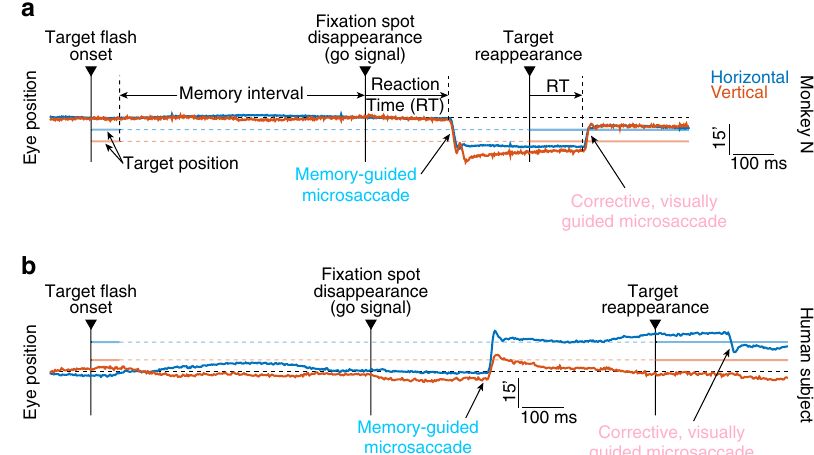
Fig. 1 Memory-guided microsaccades in monkeys and humans. a Eye position measurements from an example trial in monkey N. Upward de fl ections in each trace mean rightward or upward eye position displacements, respectively, and the position scale bar denotes 15 min arc. A brief target fl ash appeared 6 min arc to the left of and 12 min arc below fi xation. After a memory interval, the fi xation spot disappeared, instructing a memory-guided eye movement towards the remembered fl ash location. The monkey generated a spatially accurate memory-guided microsaccade after a reaction time (RT) of approximately 206 ms from fi xation spot disappearance. When the target reappeared, a smaller, corrective movement (which was now visually guided) was triggered after a shorter reaction time. b Similar observations from an example trial in a human subject. In this case, the target fl ash occurred at 18 min arc to the right of and 6 min arc above fi xation. Note that the human data were recorded with a video-based eye tracker; monkey N data were obtained from a scleral search coil (Methods). Figures 2 – 4 and Supplementary Figs. 2 – 4 demonstrate the robustness of the observations in this fi gure across